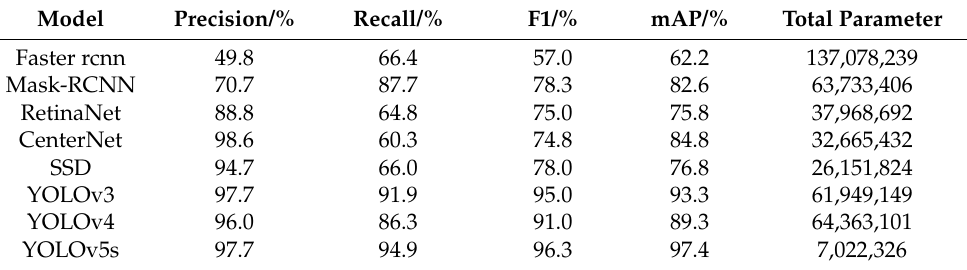
Table 5. Comparison between different target detection